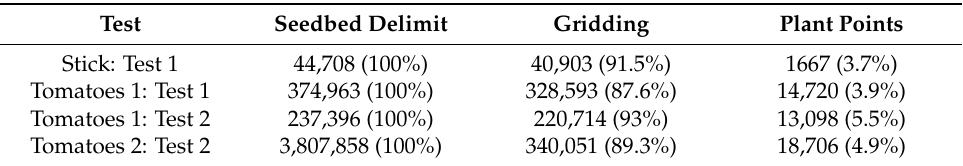
Table 7. Point cloud reduction during plant point cloud extraction.